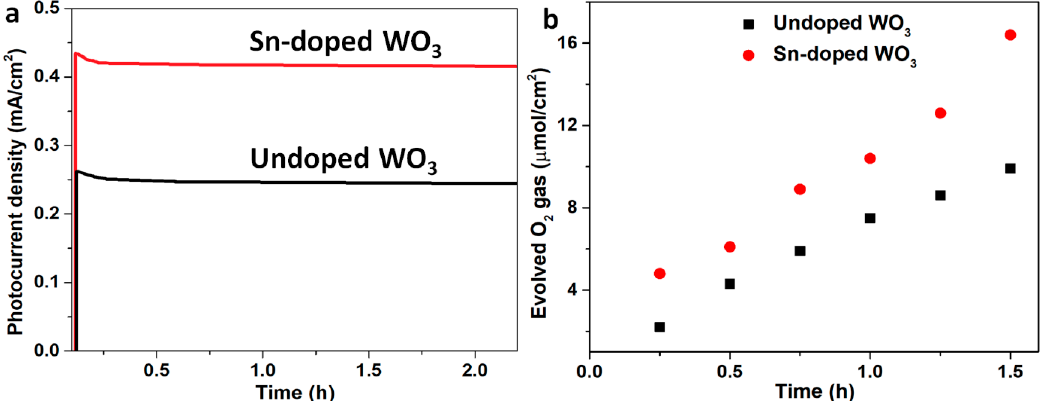
Figure 9. ( a ) Transient voltammogram of undoped and Sn-doped WO 3 thin films measured under AM 1.5 G illumination at an applied bias potential of 1.23 V RHE. ( b ) The evolution of O 2 gas at the photoanode measured for undoped and Sn-doped WO 3 under AM 1.5 G illumination at an